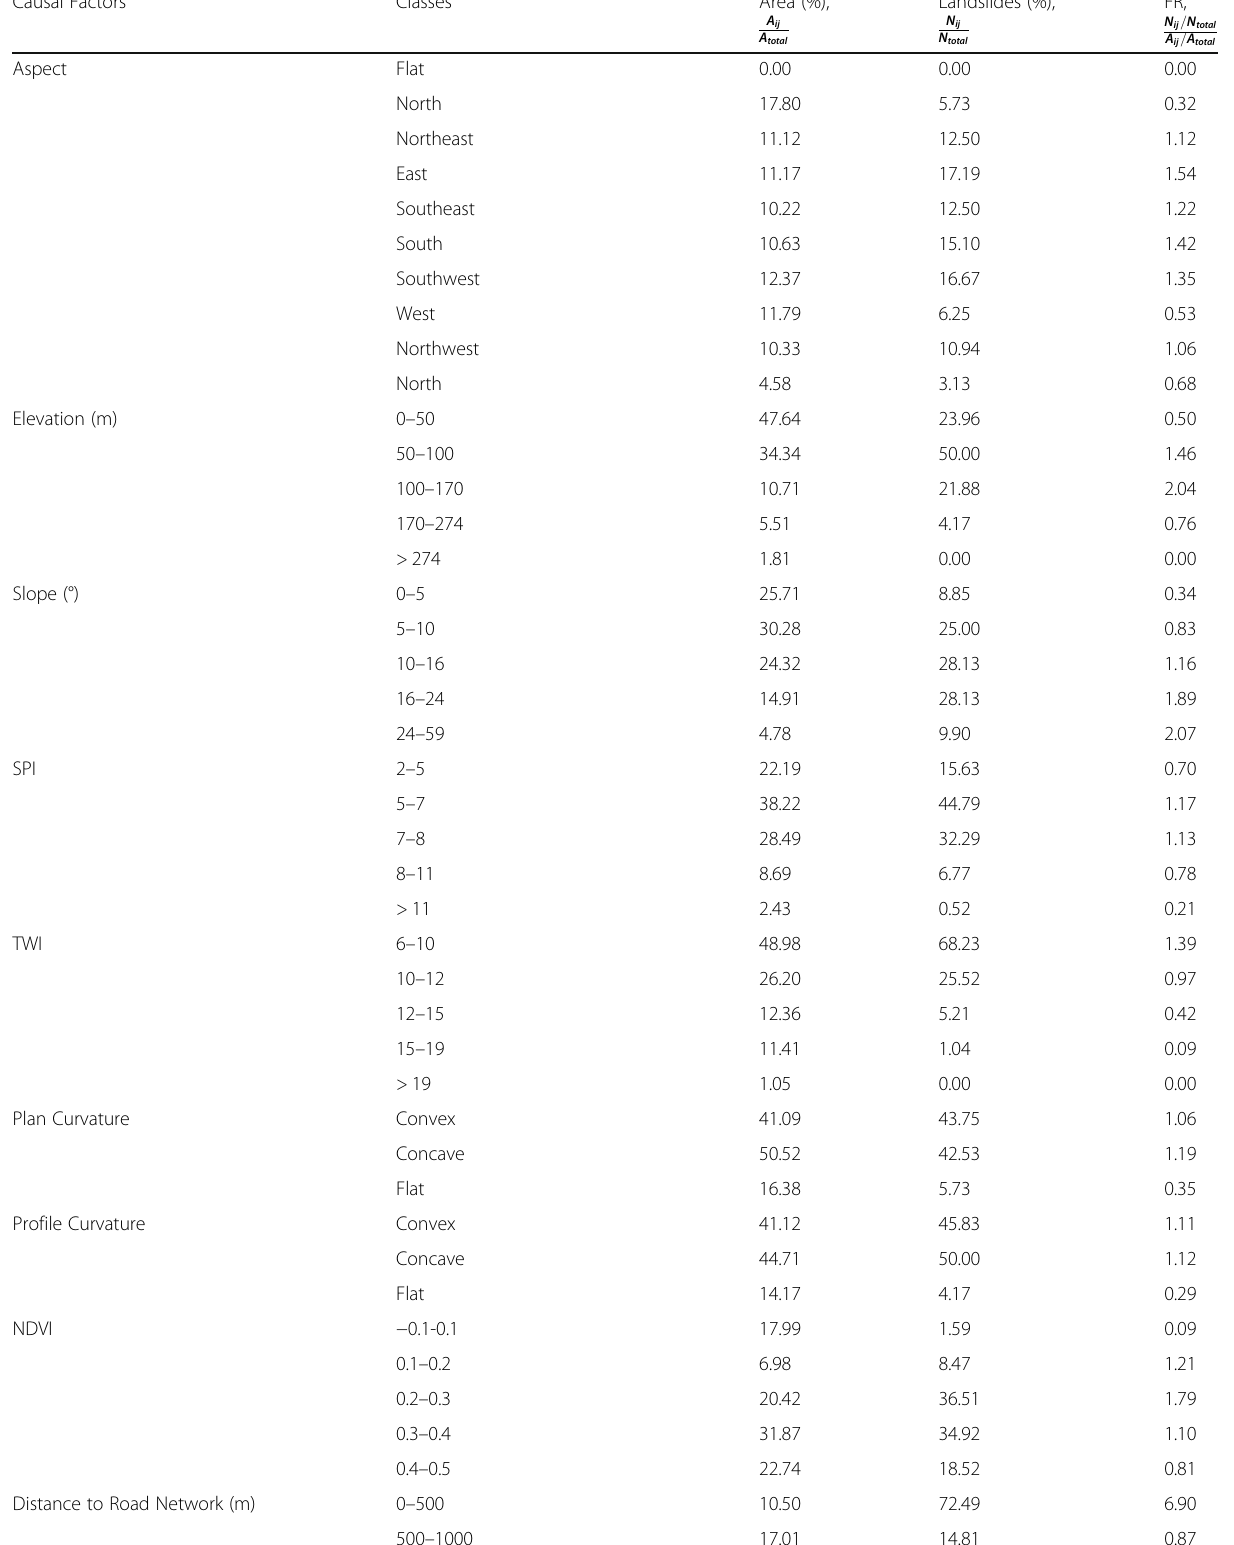
Table 2 Frequency Ratios of Landslide Causal